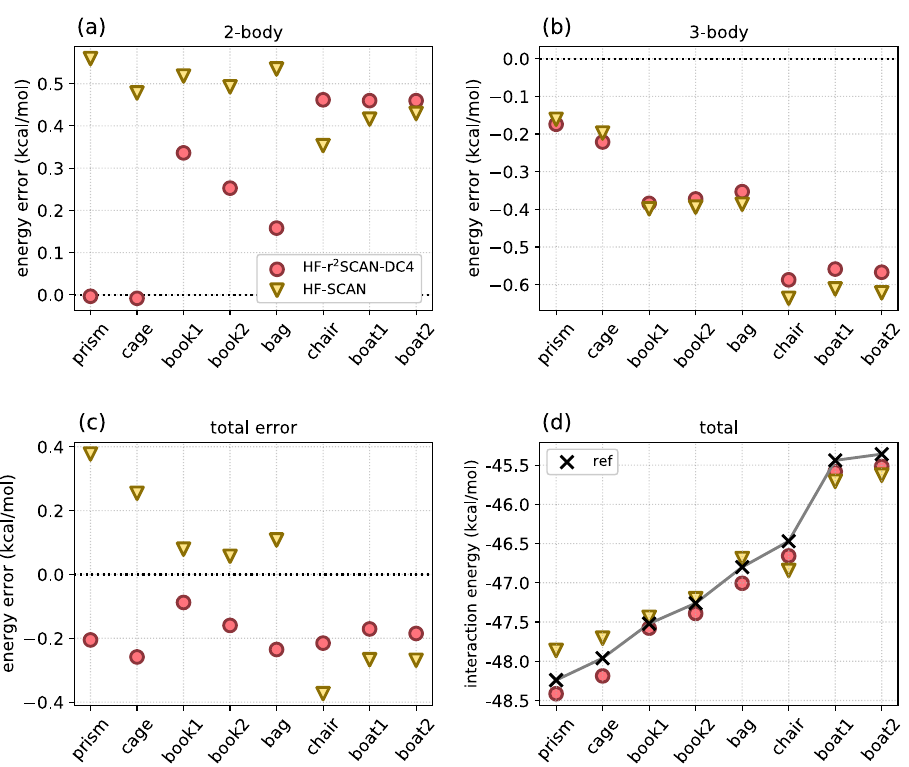
Fig. 3 | K-body interaction energy errors. a K =2, b K =3, and c total, and d the interaction energy for 8 water hexamers. (For higher order K -body interaction energies,seeSupplementaryFigs.5and6.)GeometriesandCCSD(T)/CBSreference